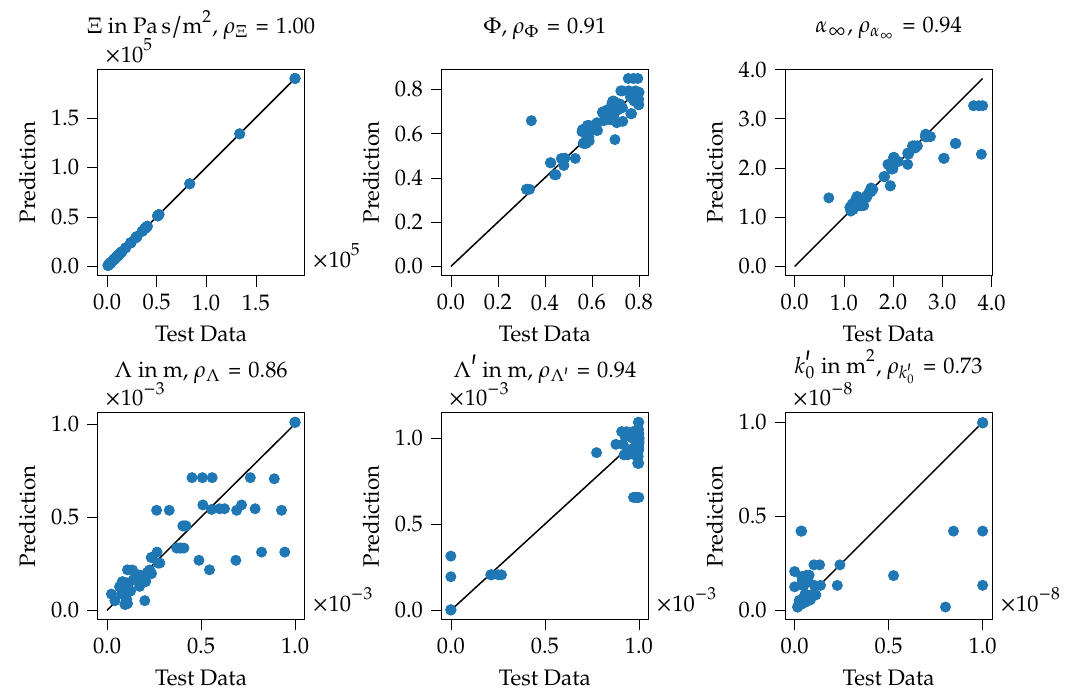
Figure 13. Correlation graphs for inversely identified Biot parameters and their corresponding prediction by the ANN model. It can be seen that all quantities are predicted with reasonable accuracy, thus the model is qualified for further application.